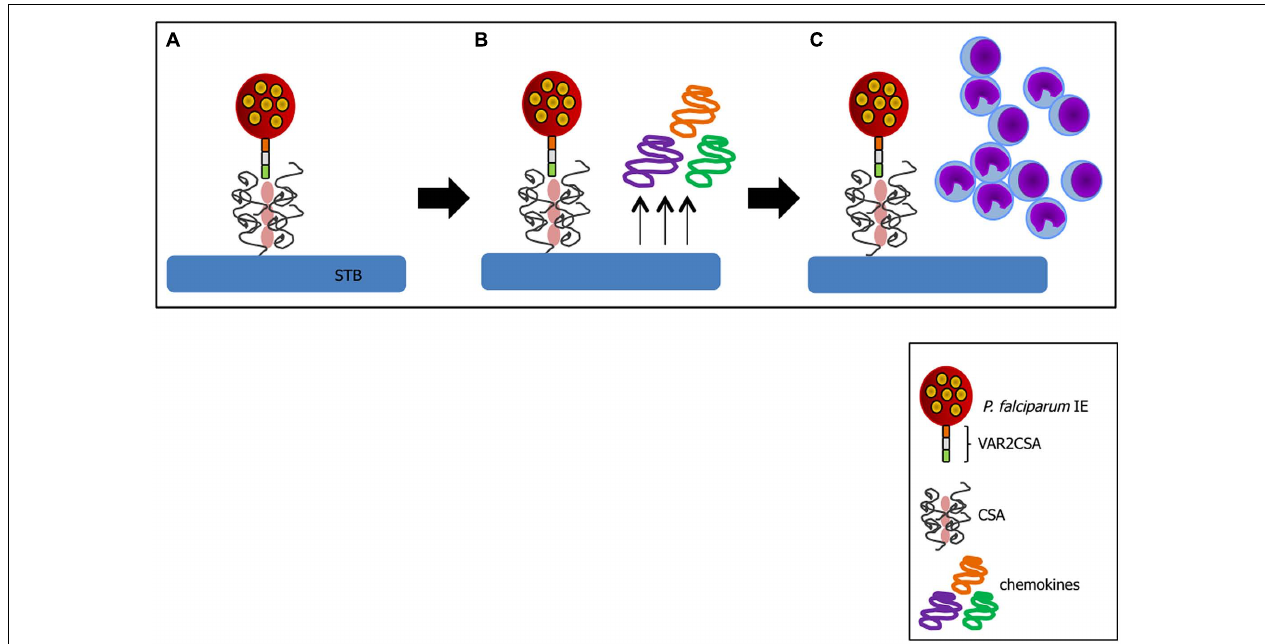
cells to the site (C) . Sequence of events compiled based on studies from (Fried and Duffy, 1996; Salanti etal., 2004; Lucchi etal., 2008; Srivastava etal.,